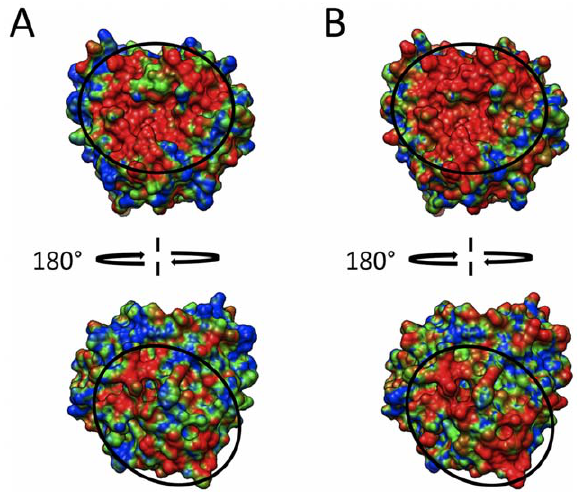
Figure 4. Electrostatic similarity distributions for perturbed human C3d structures. (A) Perturbation map for a 20 ns explicit- solvent MD simulation, based on 200 snapshots (extracted every 100 ps). (B) Perturbation map based on a theoretical alanine scan, consisting of 64 charged residue to alanine mutations. Color scheme is: blue – green – red; low to high similarity, corresponding to ESI values of 0.5–0.7–0.9.